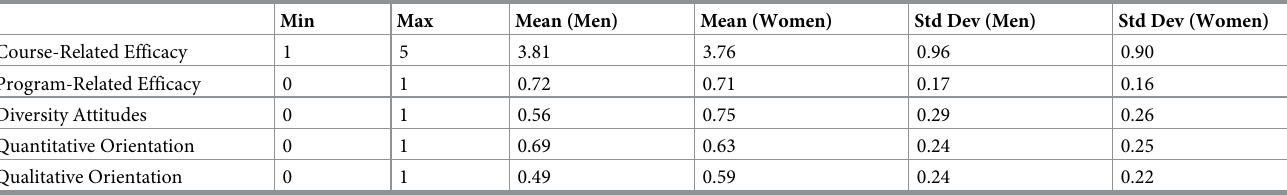
Table 2. Summary statistics for dependent variables and key independent variables, by respondent